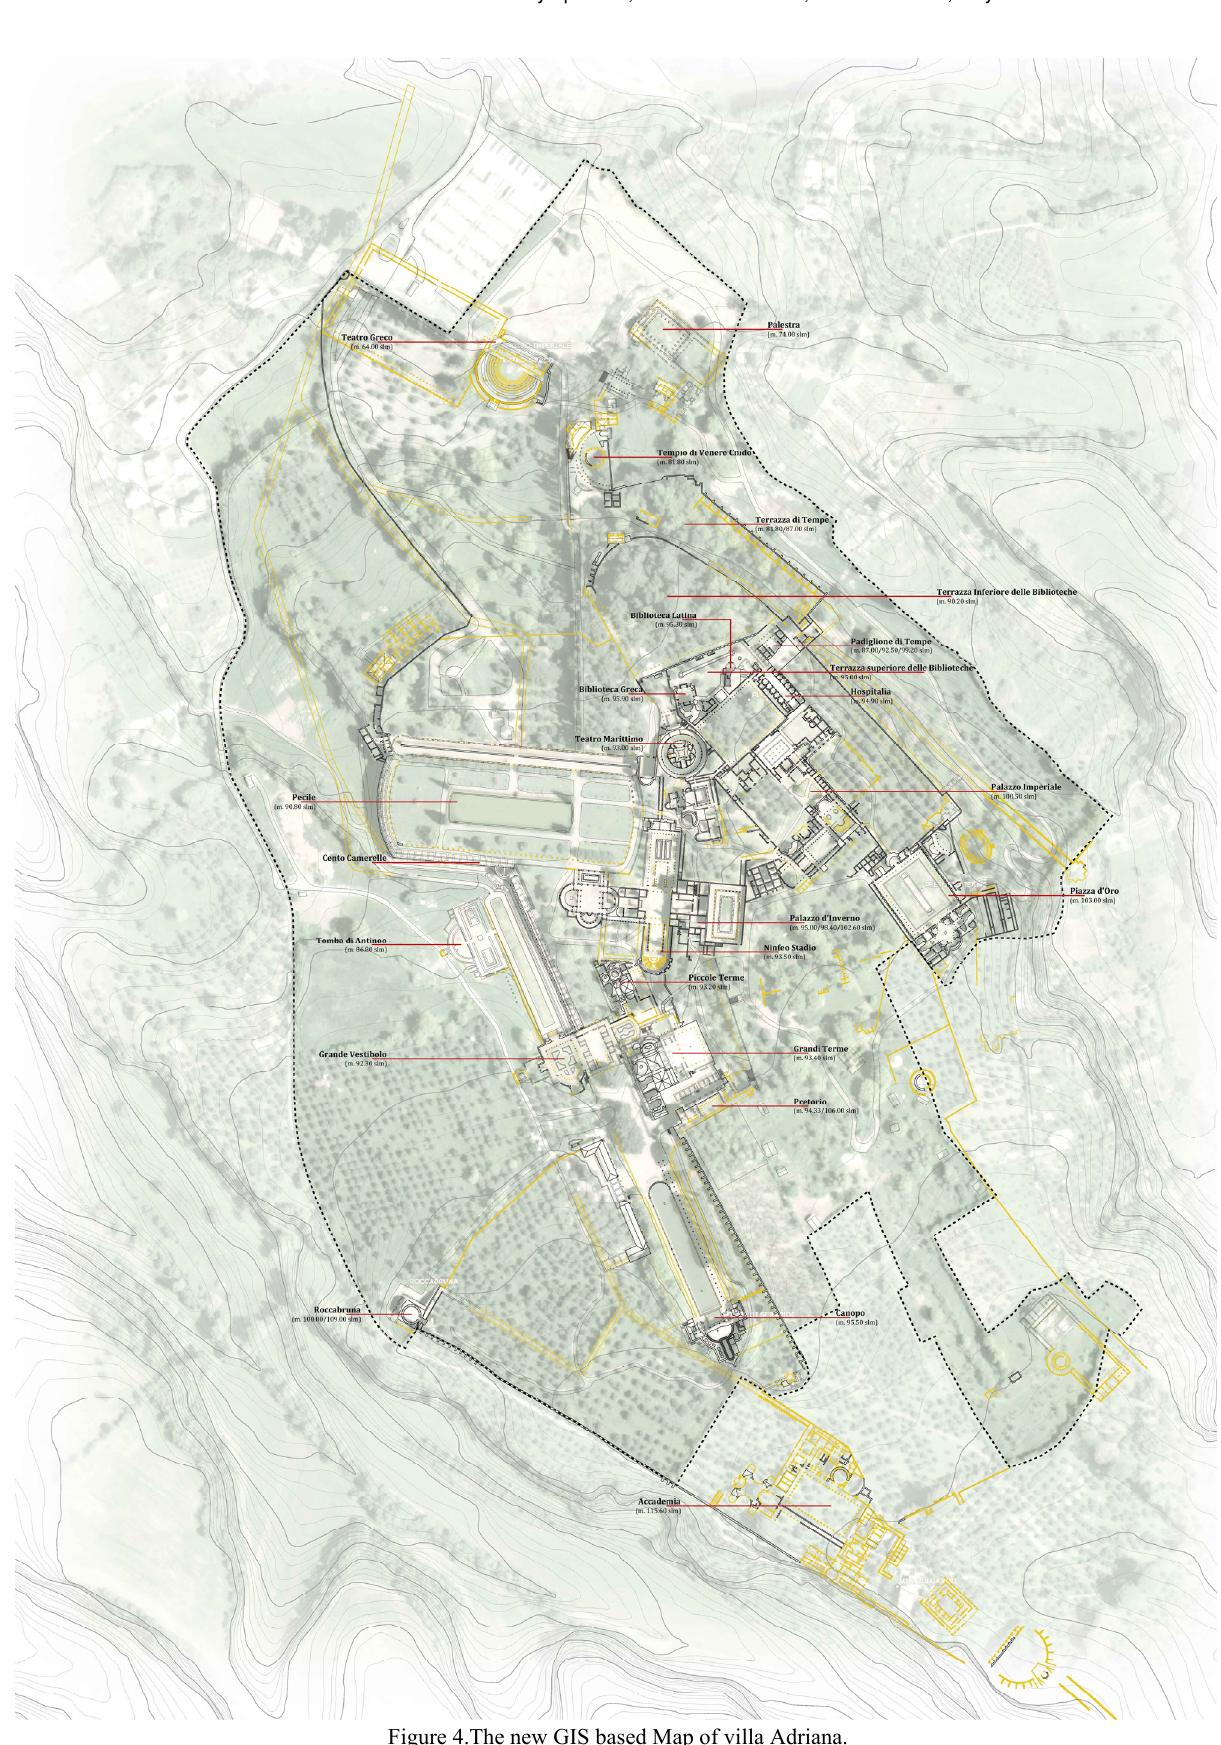
Figure 4.The new GIS based Map of villa